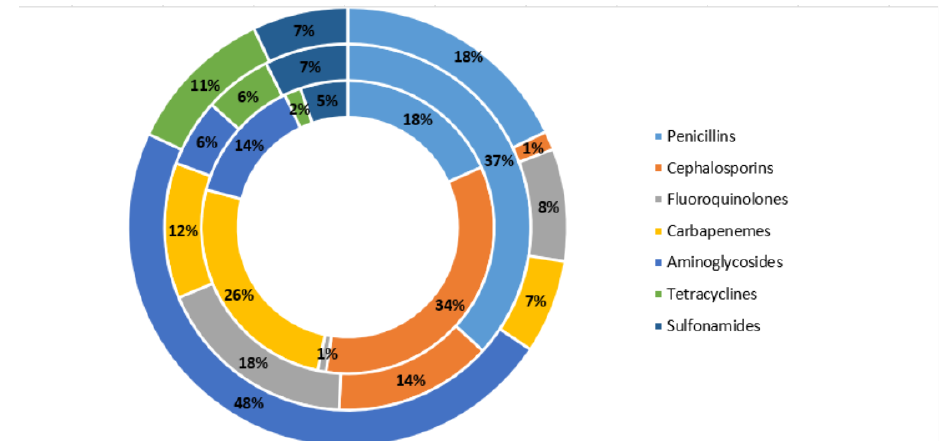
Figure 2. Distribution of the percentage of resistance, intermediate susceptibility, susceptibility for the tested antibiotic classes. Resistance is reported in the outermost circle, intermediate susceptibility is reported in the middle circle, susceptibility is reported in the inner